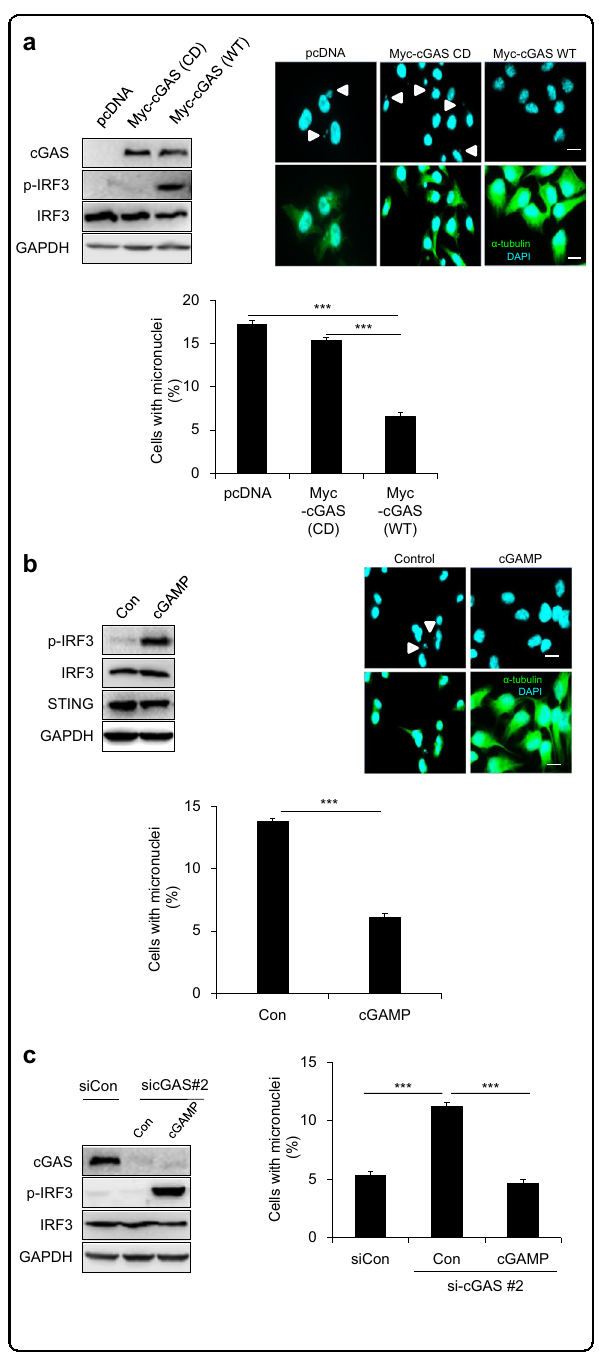
Fig. 3 cGAS activity-dependent downregulation of the micronuclei phenotype. a cGAS − / − HeLa cells were transfected with the indicated plasmids for 6 h and then were treated with nocodazole for 16 h. Then, mitotic cells were collected by shaking the plate, and they were subjected to western blotting (left panel) with the indicated antibodies. Further, ICC (right panel) was performed to determine the percentage of cells showing micronuclei 10 h after release from nocodazole, and representative fl uorescent images show micronuclei (white arrowhead denotes micronuclei). The results are given as the mean ± SD from three independent experiments ( n = 300). *** P < 0.001 as assessed by Student ’ s t -test. b cGAS − / − HeLa cells were transfected with or without cGAMP using Lipofectamine ® 2000 transfection reagent and were then incubated for 6 h. Then, the cells were arrested at the M phase via nocodazole treatment for 16 h. A portion of the mitotic cells were seeded on a coverslip to enumerate the cells showing a micronuclei phenotype 10 h after release from arrest, as assessed by ICC (right panel) along with representative fl uorescent images showing micronuclei (white arrowhead denotes micronuclei). The remaining portion of cells was subjected to western blotting with the indicated antibodies (left panel). The results are given as the mean ± SD from three independent experiments ( n = 300). *** P < 0.001 as assessed by Student ’ s t -test. c HeLa cells transfected with sicGAS for 20 h were transfected with or without cGAMP for 6 h and then subjected to nocodazole treatment for 16 h. Ten hours after release from nocodazole treatment, western blotting (left panel) with the indicated antibodies and ICC (right panel) was performed to quantify cells displaying a micronuclei phenotype. The results are given as the mean ± SD from three independent experiments ( n = 300). *** P < 0.001 as assessed by Student ’ s t